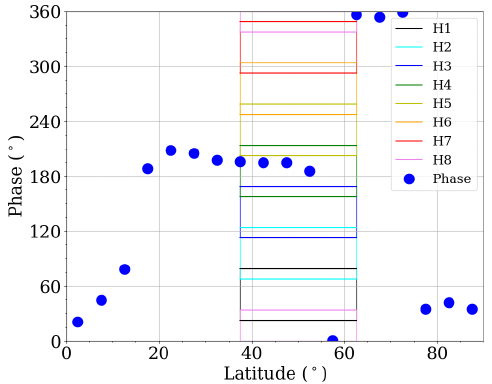
Figure 7. Zonal wind SPW 1 phase of the Ref simulation (blue dots). The positions of the GW hotspots are illustrated by the col- ored